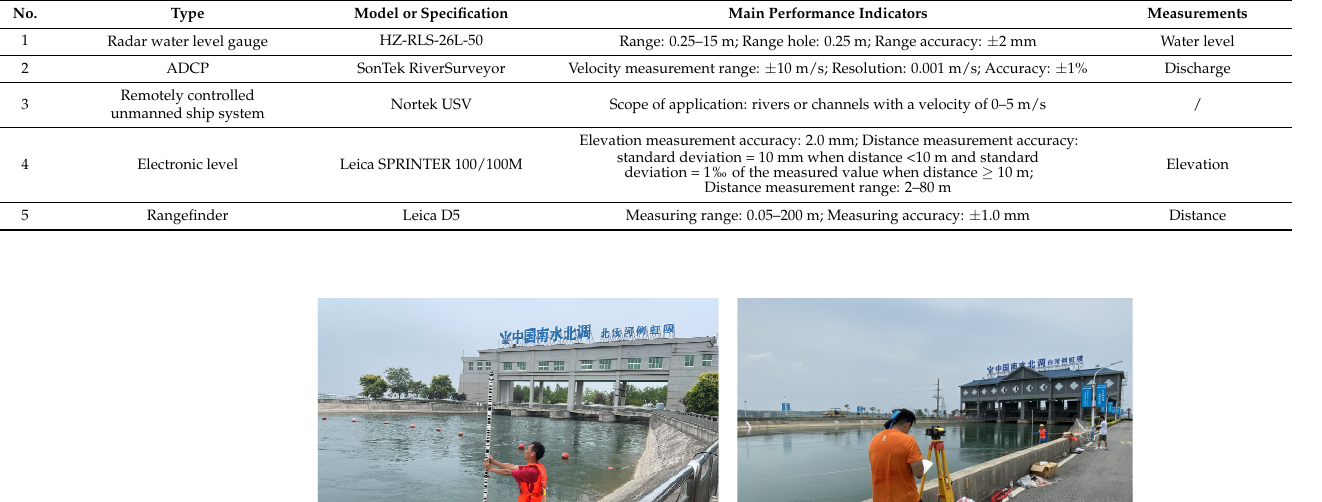
Table 2. Observation instruments and performance parameters.